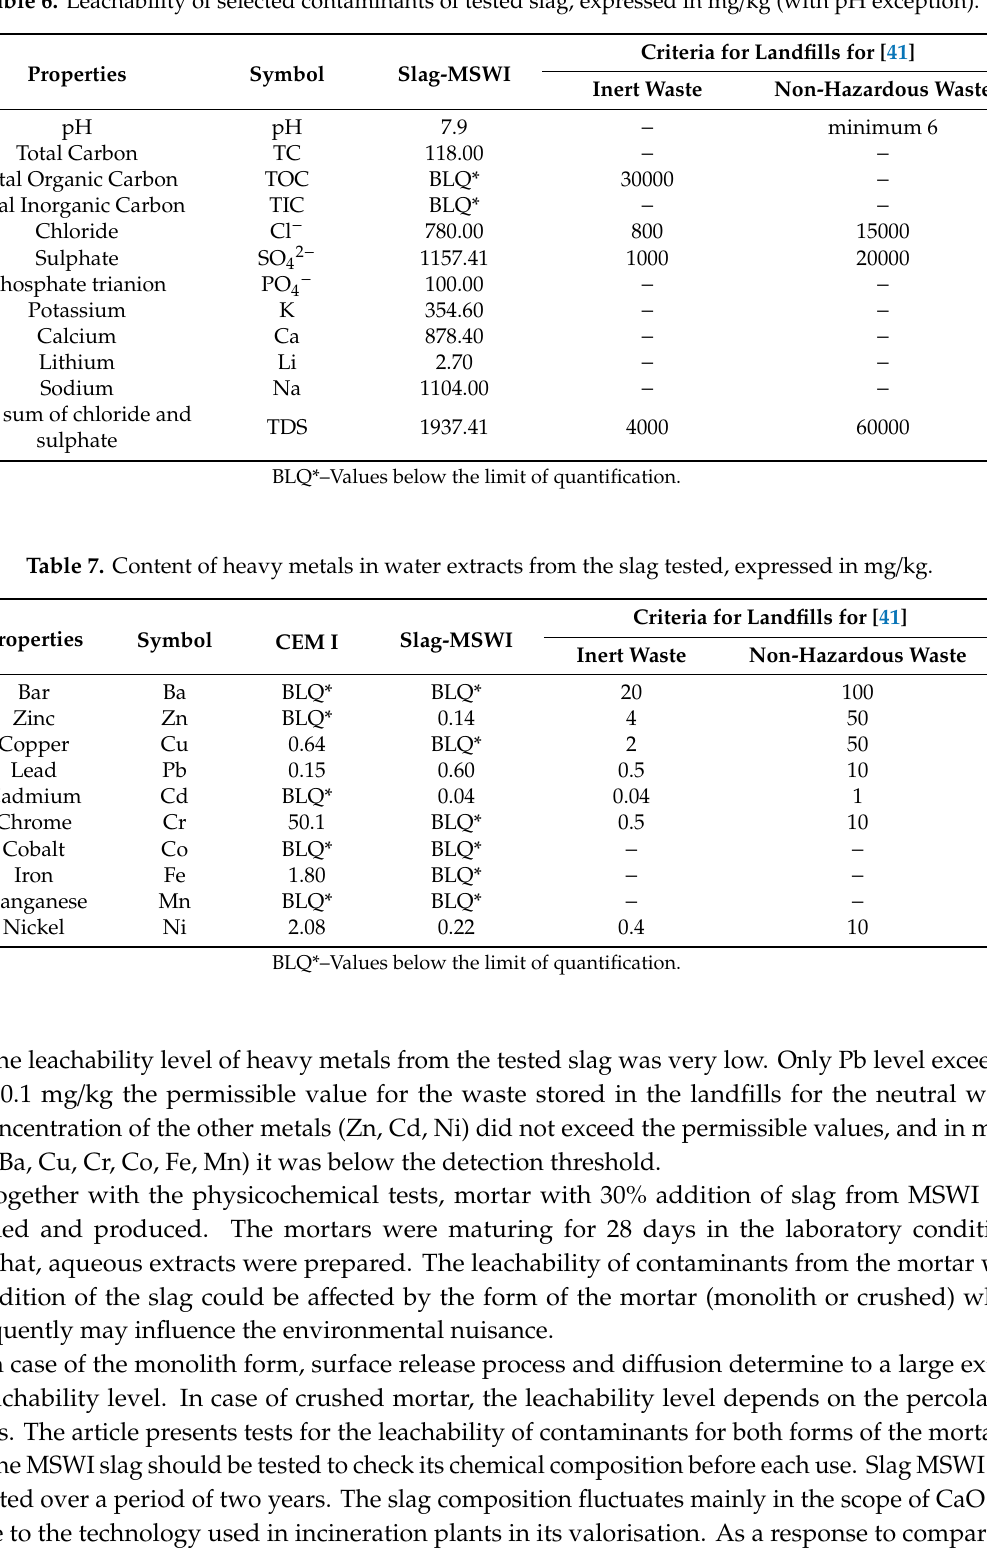
Table 6. Leachability of selected contaminants of tested slag, expressed in mg / kg (with pH exception).